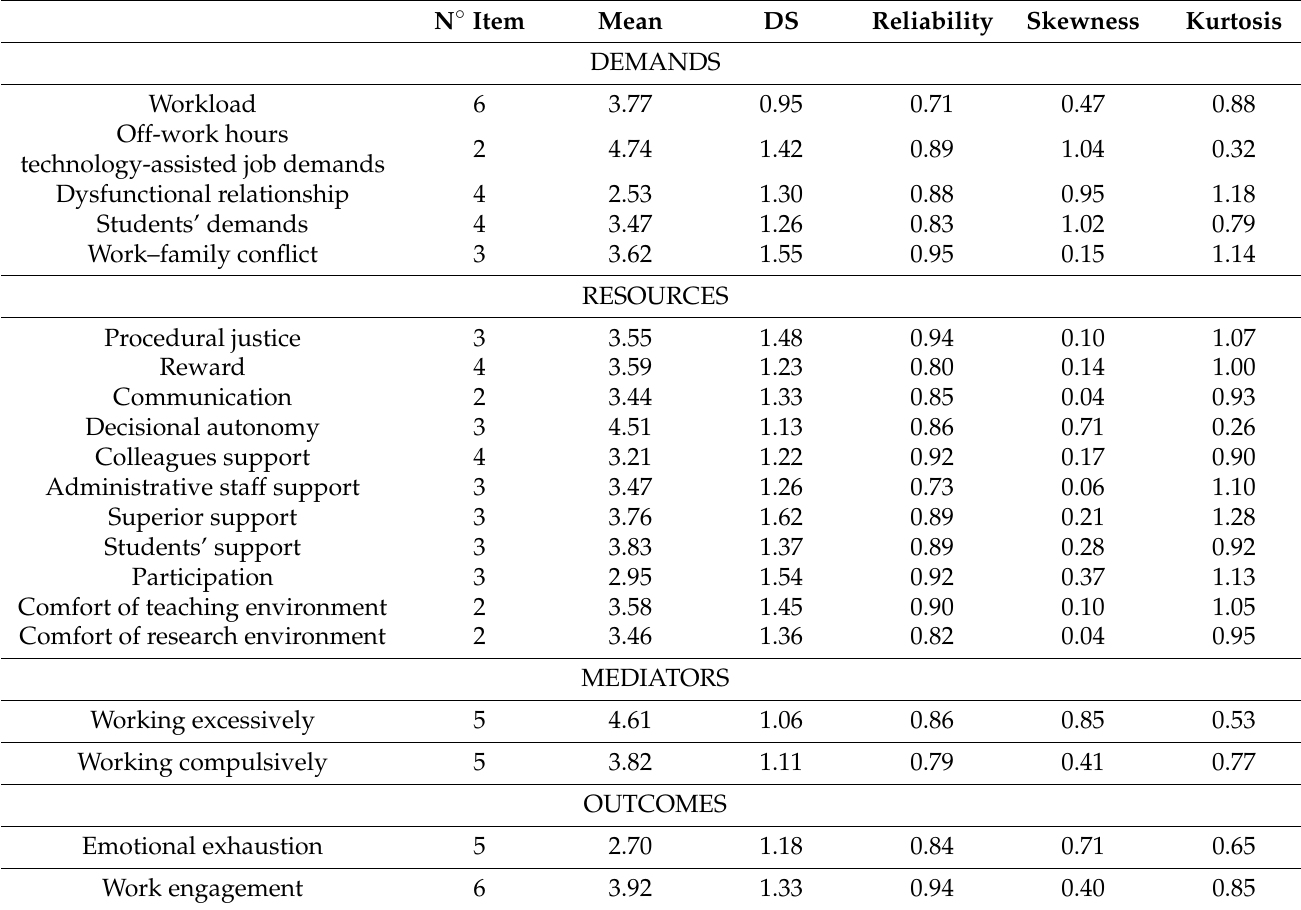
Table 3. Principal descriptive analysis of the validation sample (N =